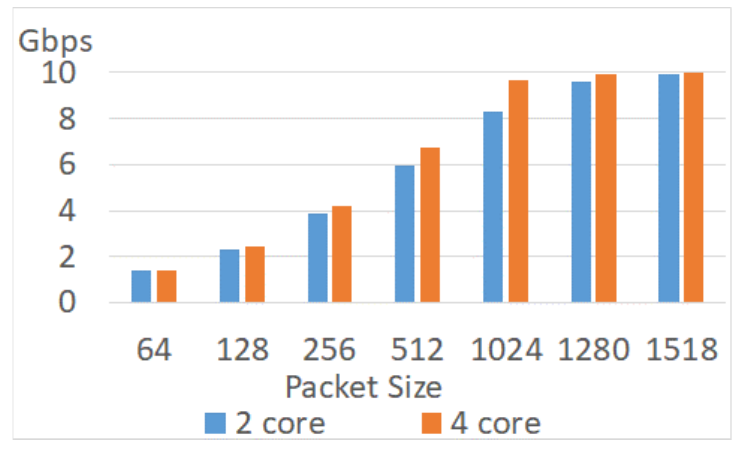
Figure 14. Throughputs of VMs with different cores in the PVP scenario. The throughputs of a 2-core VM are 1.4 Gbps, 5.9 Gbps, and 9.93 Gbps when the packet sizes are 64, 512, and 1518, respectively. Regarding a 4-core VM, the throughputs are 1.42 Gbps, 6.7 Gbps, and 9.96 Gbps when the packet sizes are 64, 512, and 1518, respectively. The improvement ranges from 0.2% to 16% in this experiment. The reason is that if the VM only has two CPU cores, the preemption occurs frequently while